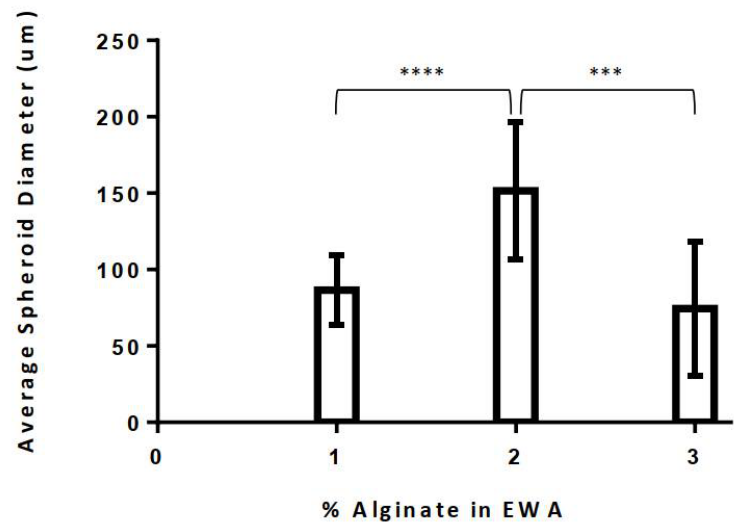
Figure 3. Comparison of spheroid sizes on different alginate concentrations for EWA hydrogel. The value of each bar shown was reported as a mean where n = 15 for each group. Sample images were taken at random, where the five largest spheroids within each image were identified and had its diameter measured. The average spheroid diameter size from each treatment was then reported. Statistical significance was analyzed using a RM one-way ANOVA, multiple comparison test with the Greenhouse–Geisser correction, where *** represents p < 0.001%, and **** represents p < 0.0001%. The error bars shown represent the SE of each group.